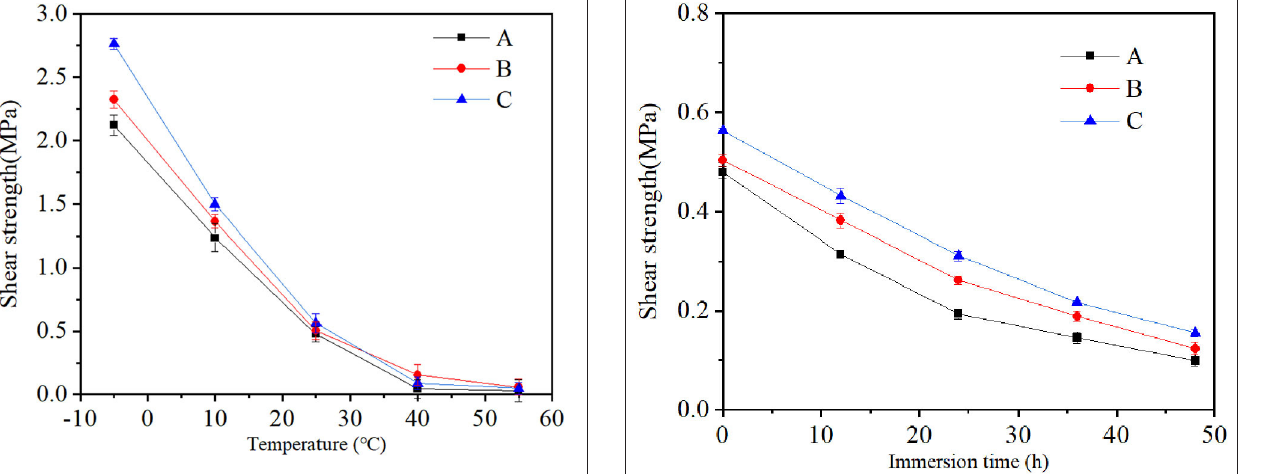
FIGURE 6 | Interfacial shear strength at different